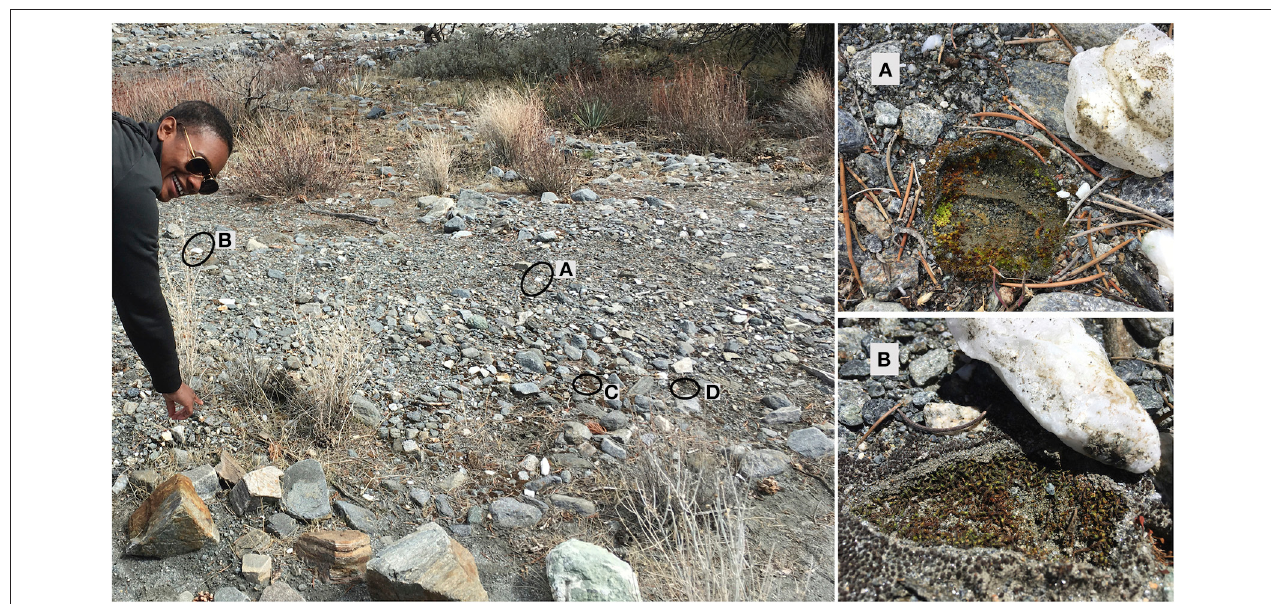
FIGURE 1 | Habitat photo (Left), showing a major portion of the collection area with locations of two hypoliths harboring moss biocrusts indicated [ A,B —corresponding to the photos in (A,B) to the right of the figure]. Representative moss (C) and microbial (D) biocrusts are also indicated. Inset (A) : moss hypolith showing mosses in their hydrated state; the surface biocrust adjacent to this hypolith is microbial, toward the upper left of the panel. Inset (B) : moss hypolith in desiccated state, with moss biocrusts on the soil surface adjacent to the